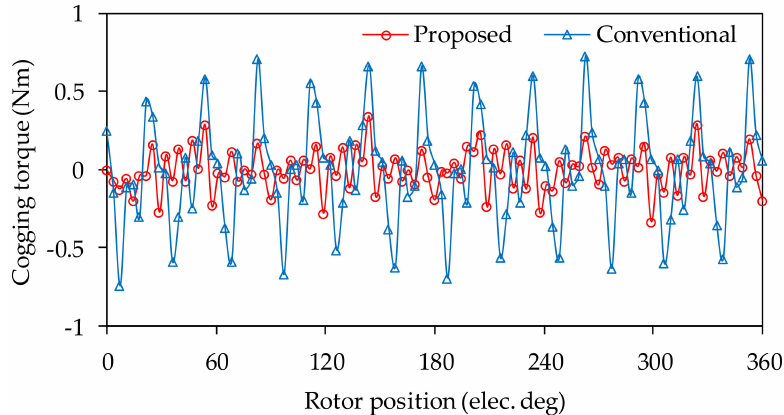
Figure 11. Cogging torques.